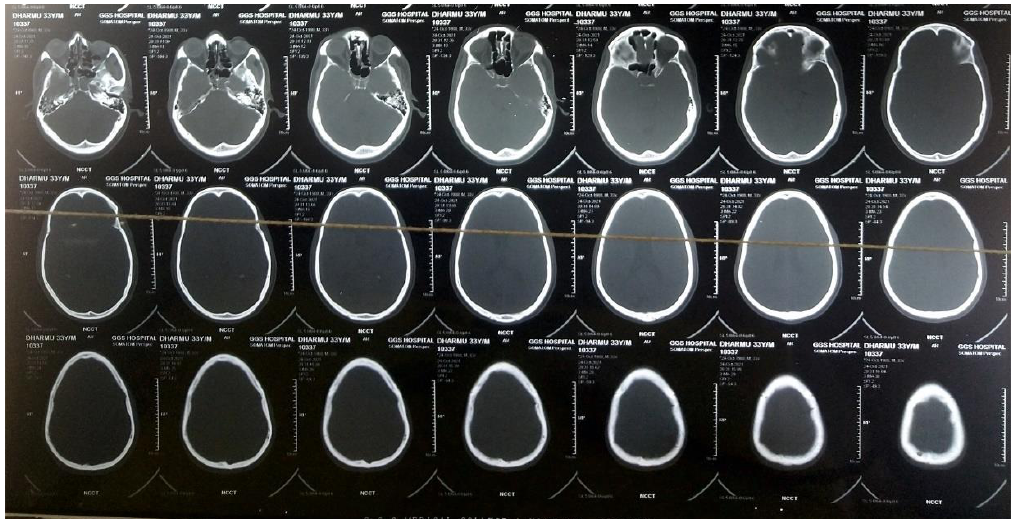
Figure 1. CT scan image showing hairline fracture of the right petrous temporal bone of the patient.